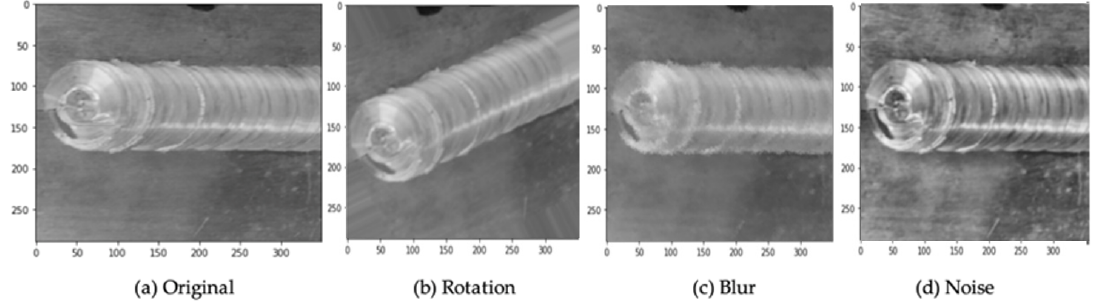
Figure 5. Image augmentation example.